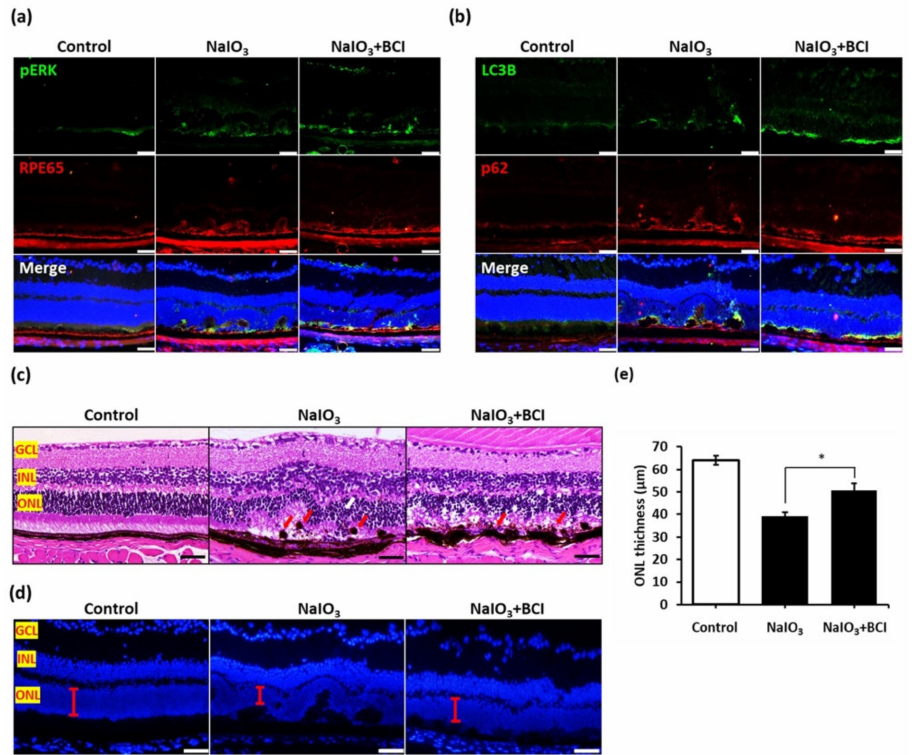
Figure 6. BCI activated autophagic flux via the upregulation of the ERK pathway in vivo. ( a ) Im- munofluorescence staining of p-ERK in mice retinas with BCL treatment. 50 µ m. ( b ) Immunofluo- rescence staining of LC3B and p62 in mice retinas with BCI treatment. 50 µ m. ( c ) The morphology of mice retinas with BCI treatment was confirmed by H&E staining and ( d ) immunofluorescence staining. The red bar shows the thickness of the ONL layers. Scale bar = 50 µ m. ( e ) Retinal thickness was calculated using Image J. * p value < 0.05 comparison to NaIO 3